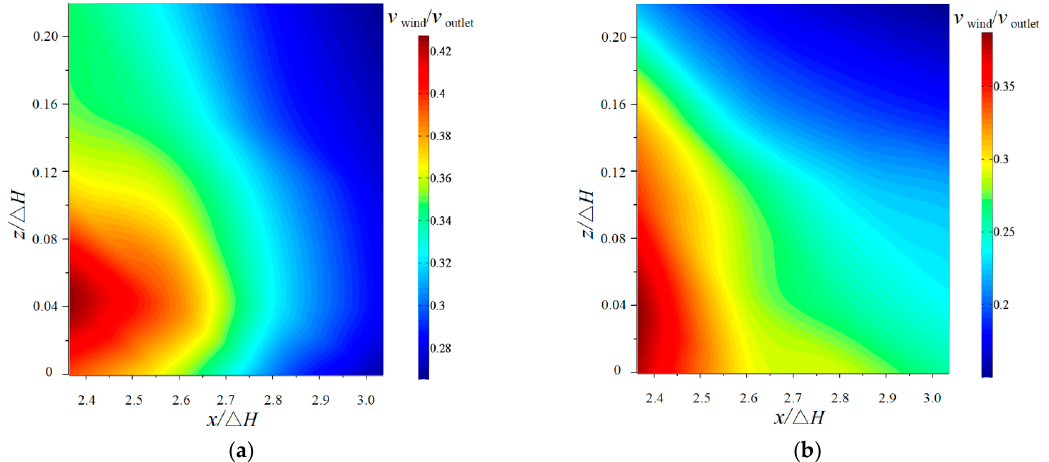
Figure 8. Vertical distribution of velocity of the nappe wind ( y / ∆ H = 0): ( a ) CB, and ( b ) TB.